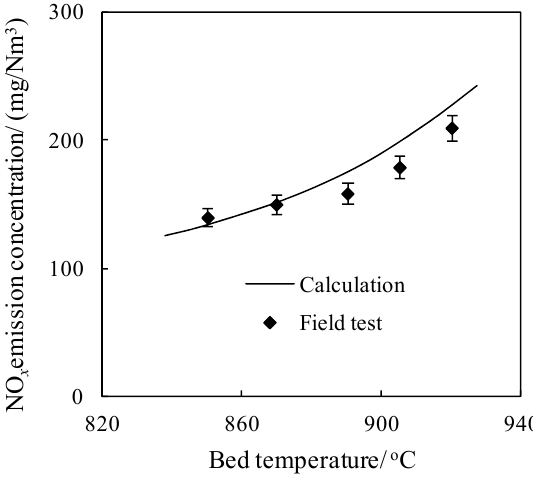
Figure 7. E ff ect of bed temperature on NO x emission concentration. Figure 7. Effect of bed temperature on NO x emission concentration.